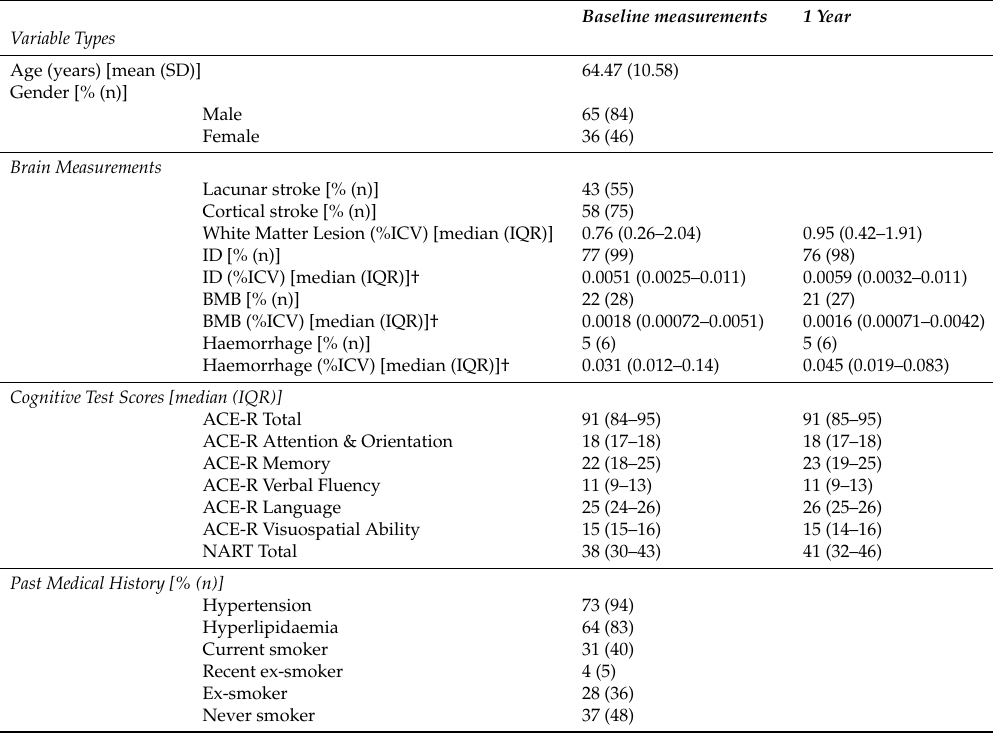
Table A1. Descriptive statistics of the subsample used in the ANCOVA analyses (i.e., patients with complete ID measurements and cognitive test results at diagnosis/first wave of cognitive testing and 1 year after) ( n = 129). For simplification of tabular presentation, percentages (%) are rounded to the closest integer number (elsewhere, test percentages are shown up to two significant decimal places).